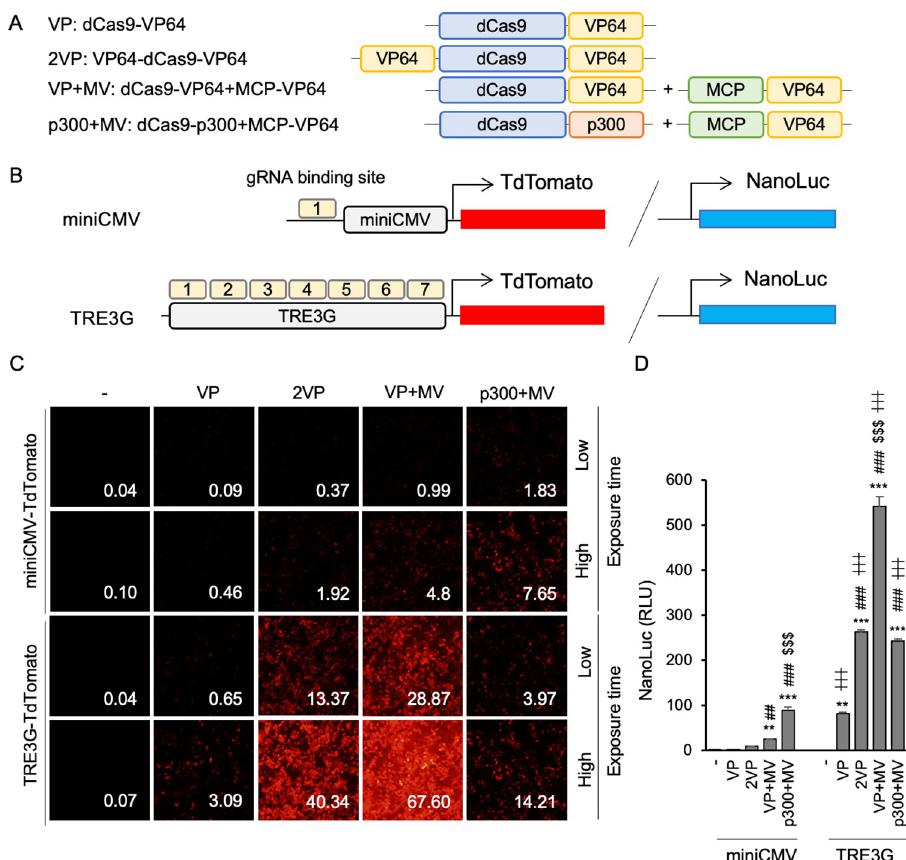
Fig 5. CRISPRa-mediated transcriptional activation of exogenous TdTomato and NanoLuc reporter constructs. (A) Schematic diagrams of the CRISPRa-VP64 and -p300 systems used. (B) Schematic diagrams of TdTomato and NanoLuc reporter gene constructs. The miniCMV-driven reporter construct has one gRNA binding site, whereas the TRE3G-driven reporter construct has seven identical gRNA binding sites. (C) TdTomato fluorescence in HEK293T cells transfected with the indicated reporter and CRISPRa constructs. TdTomato expression was higher for TRE3G vs. miniCMV. The strength of TRE3G induction was in the order of VP+MV > 2VP > p300+MV > VP. Fluorescence intensity is shown in the lower right corner of each image. (D) NanoLuc luminescence was measured in HEK293T cells transfected with the indicated reporter and CRISPRa constructs. The relative luminescence was higher for TRE3G vs. miniCMV. The strength of TRE3G induction was in the order of VP+MV > 2VP > p300+MV > VP. Error bars indicate the mean ± SE (n = 4). Statistical analysis was performed using one-way ANOVA with Tukey’s multiple comparisons test. �� , P < 0.01, ��� , P < 0.005 vs. non-induced control, ## , P < 0.01, ### , P < 0.005 vs. VP, $$$ , P < 0.005 vs. 2VP, , P < 0.005 vs. each corresponding miniCMV-driven level of